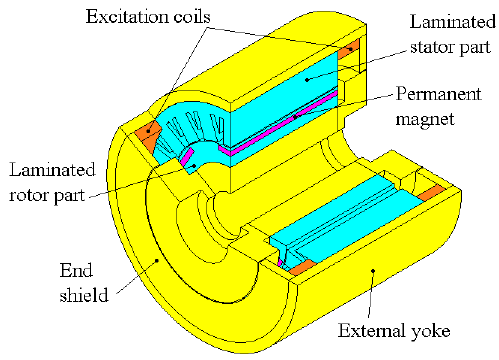
Figure 10. 3D cut view of the hybrid excitation machine.